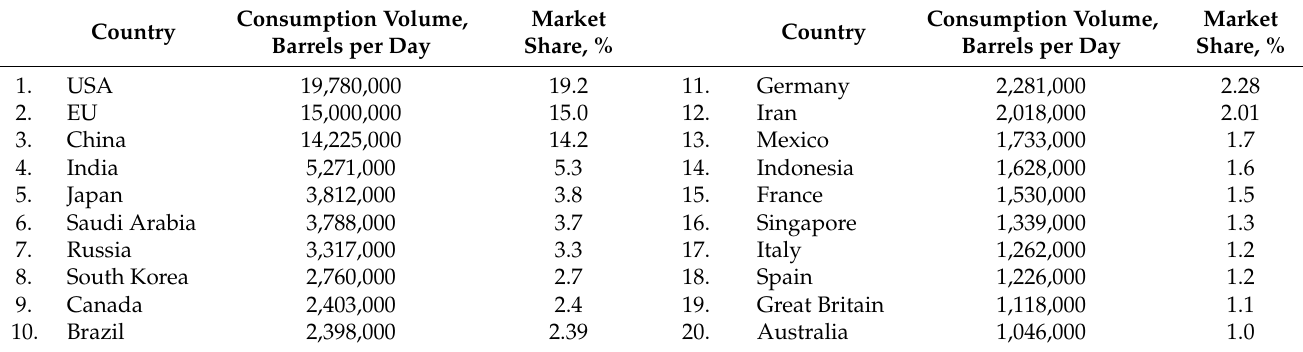
Table 3. Oil consumption in developed countries in